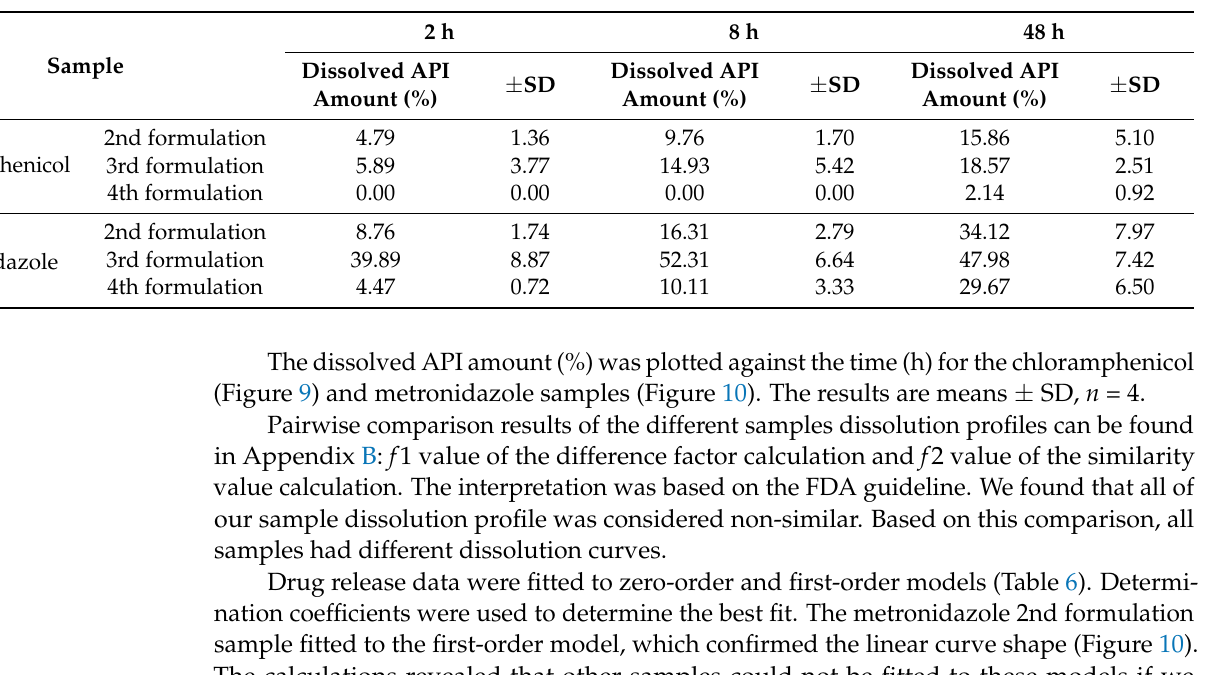
Table 5. The dissolved API amount (%) results at 2 h, 8 h, and 48 h can be found in the table and the other sampling time results in Appendix A, with the standard deviation results.